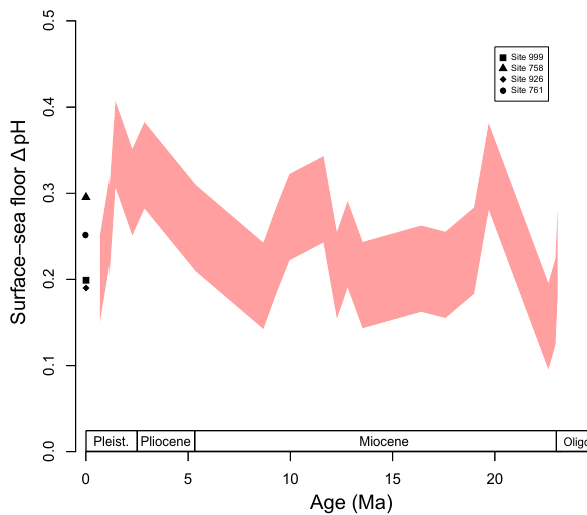
Figure 9. The pH gradient between surface and deep water through time calculated from the δ 13 C gradient and using a flat probability derived from the low-latitude ensemble regressions from the CY- CLOPS model. The modern pH gradients at each site are also plot- ted.